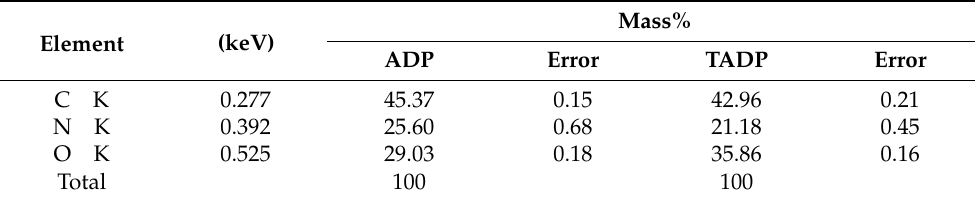
Table 1. EDX analysis of the as-prepared ADP and TADP samples.